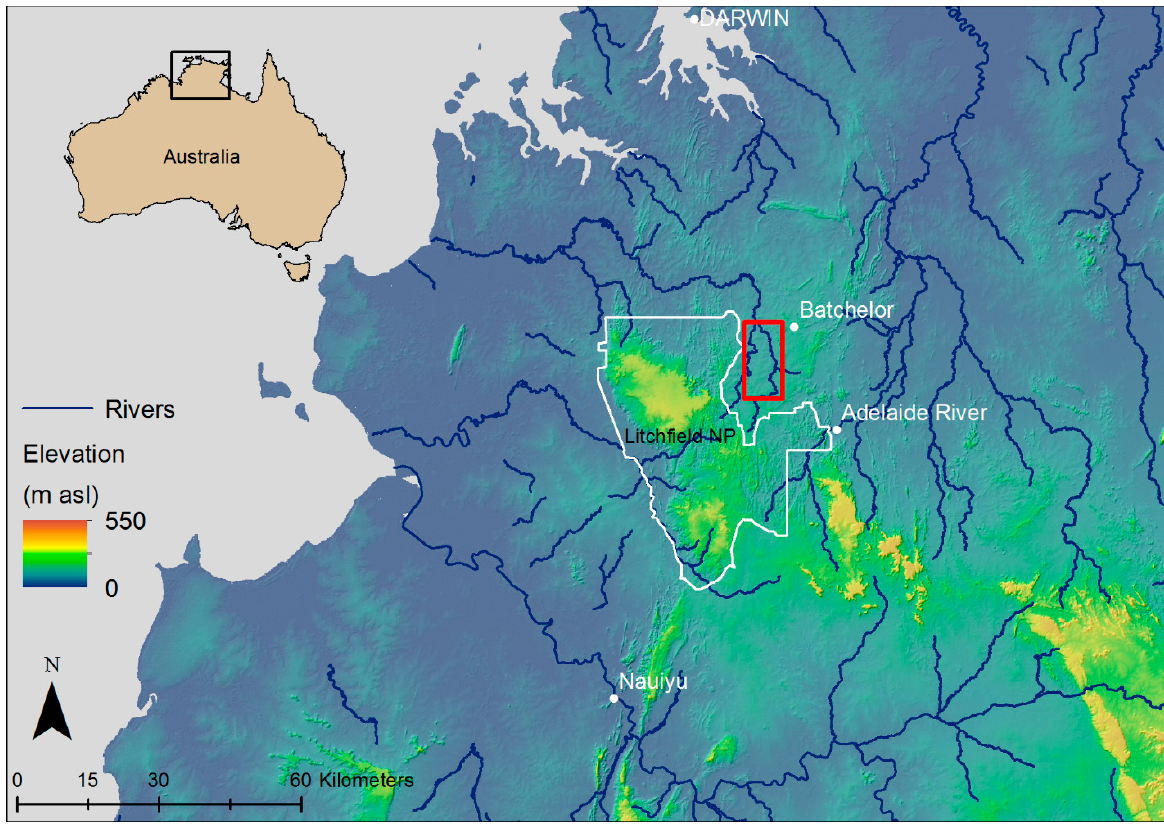
Figure 2. Study site location (red box) in the Batchelor region of the Northern Territory,